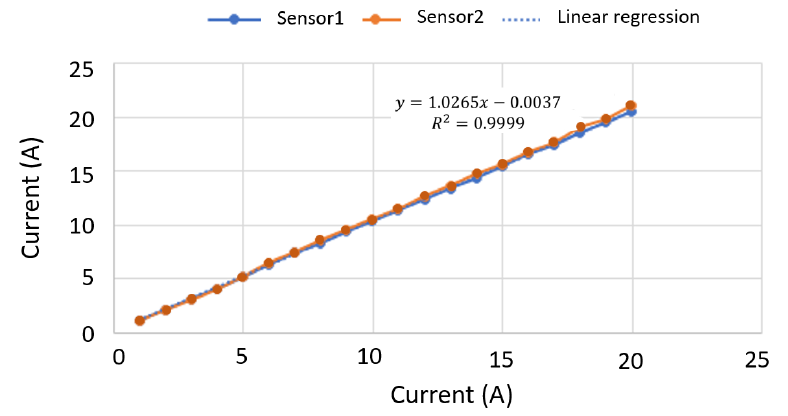
Figure 3. Current sensor calibration process: comparison of input current vs measured